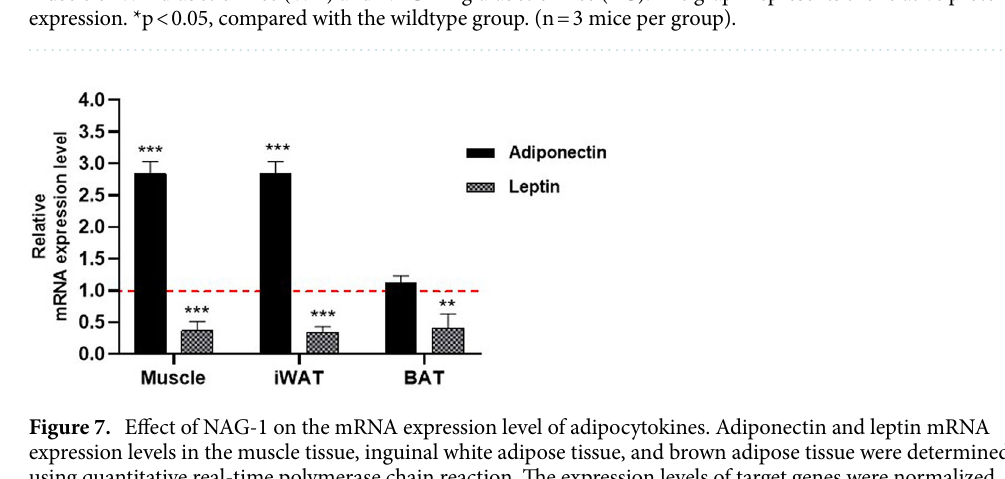
To elucidate the mechanism involved in NAG-1/GDF15-mediated enhanced insulin sensitivity, this study investigated the insulin signaling pathway in NAG-1 Tg mouse tissues using the HFD/STZ-induced diabetic